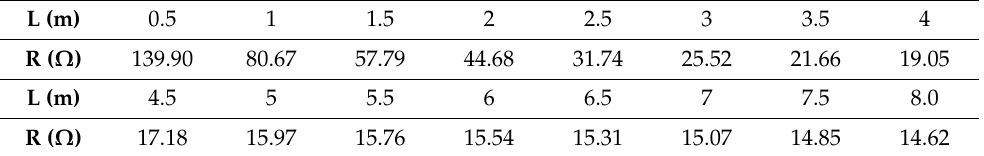
Table 1. Buried rod length L (m) and the corresponding grounding resistance R ( Ω ).